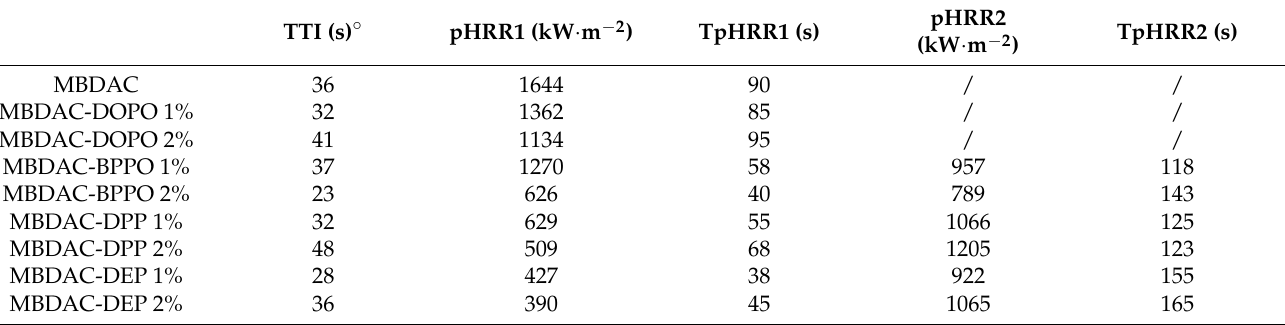
Table 4. Main data from cone calorimeter tests for all